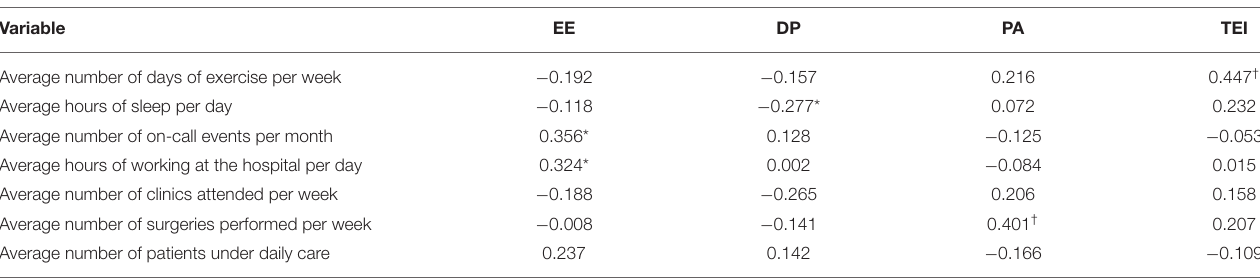
TABLE 3 | Correlations among the various factors in the present study. Variable